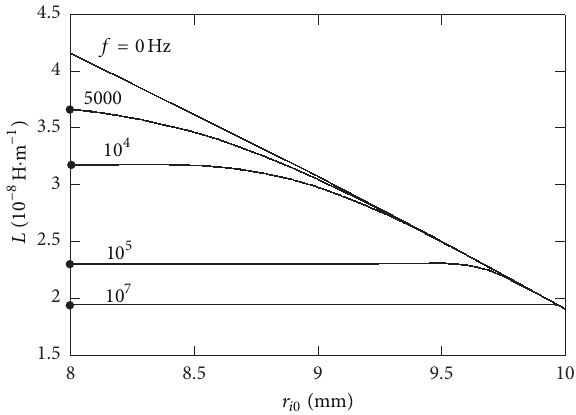
Figure 6: Dependence of inductance on radius 𝑟 𝑖0 and frequency 𝑓 in Example 2. Isolated points ∙ denote values 𝐿 for 𝑟 𝑖0 = 0 mm. If 𝑓 = 0 , then 𝐿 = 9.226 × 10 −8 H ⋅ m −1 for 𝑟